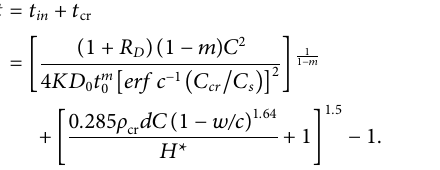
FIGURE 2 Comparison of experimental results with results predicted by the